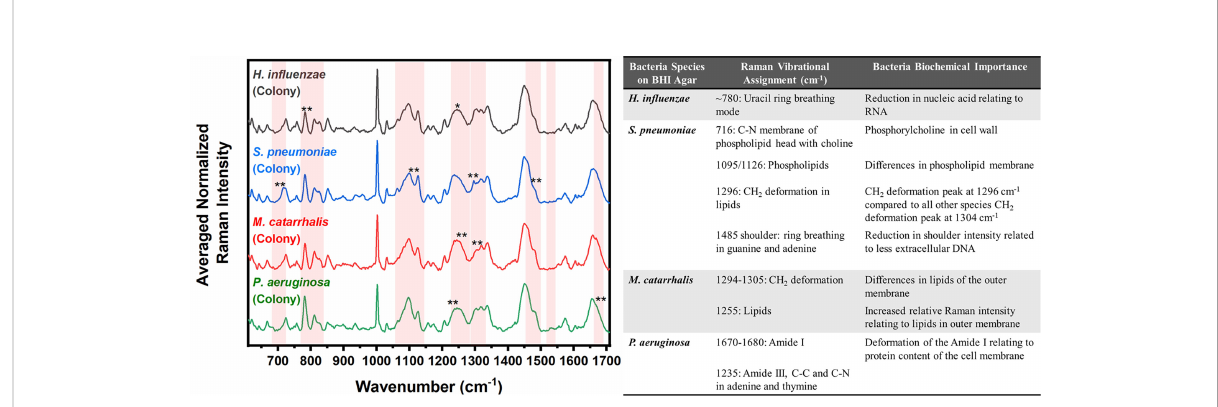
FIGURE 4 Averaged Raman spectra (left) highlighting key Raman features identi fi ed by SMLR to differentiate OM-causing bacterial colonies grown on BHI agar. The table (right) provides a summary of the tentative biochemical assignments of a few of the key Raman peaks. The red bands highlight the wavenumbers with SMLR weighted features contributing to *60-79% and ** ≥ 80% in differentiating amongst the species ’